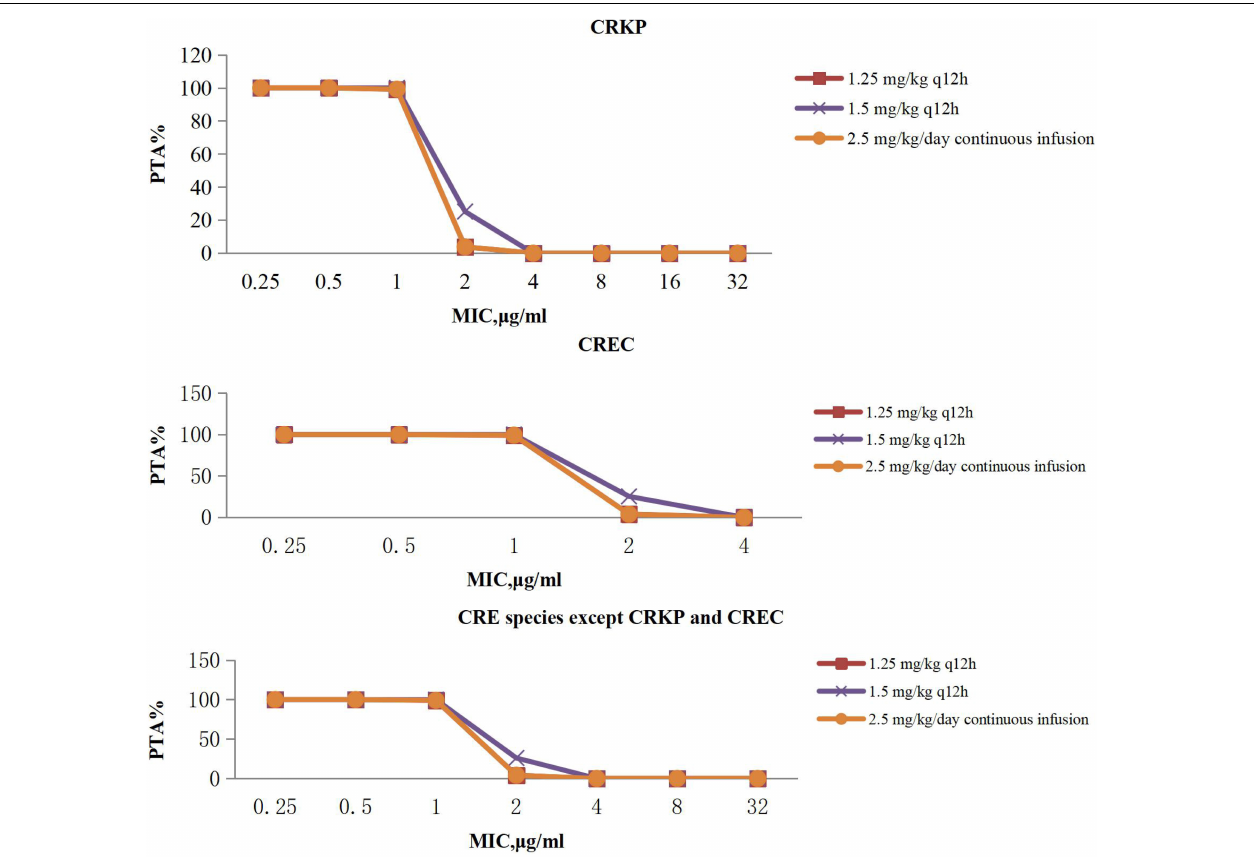
FIGURE 2 | PTA against CRE at MICs from 0.25 to 32 mg/L for polymyxin B. PTA, probability target attainment; MIC, minimum inhibitory concentration; CRE, carbapenem-resistant Enterobacterales; CRKP, carbapenem-resistant Klebsiella pneumoniae ; CREC, carbapenem-resistant Escherichia coli .